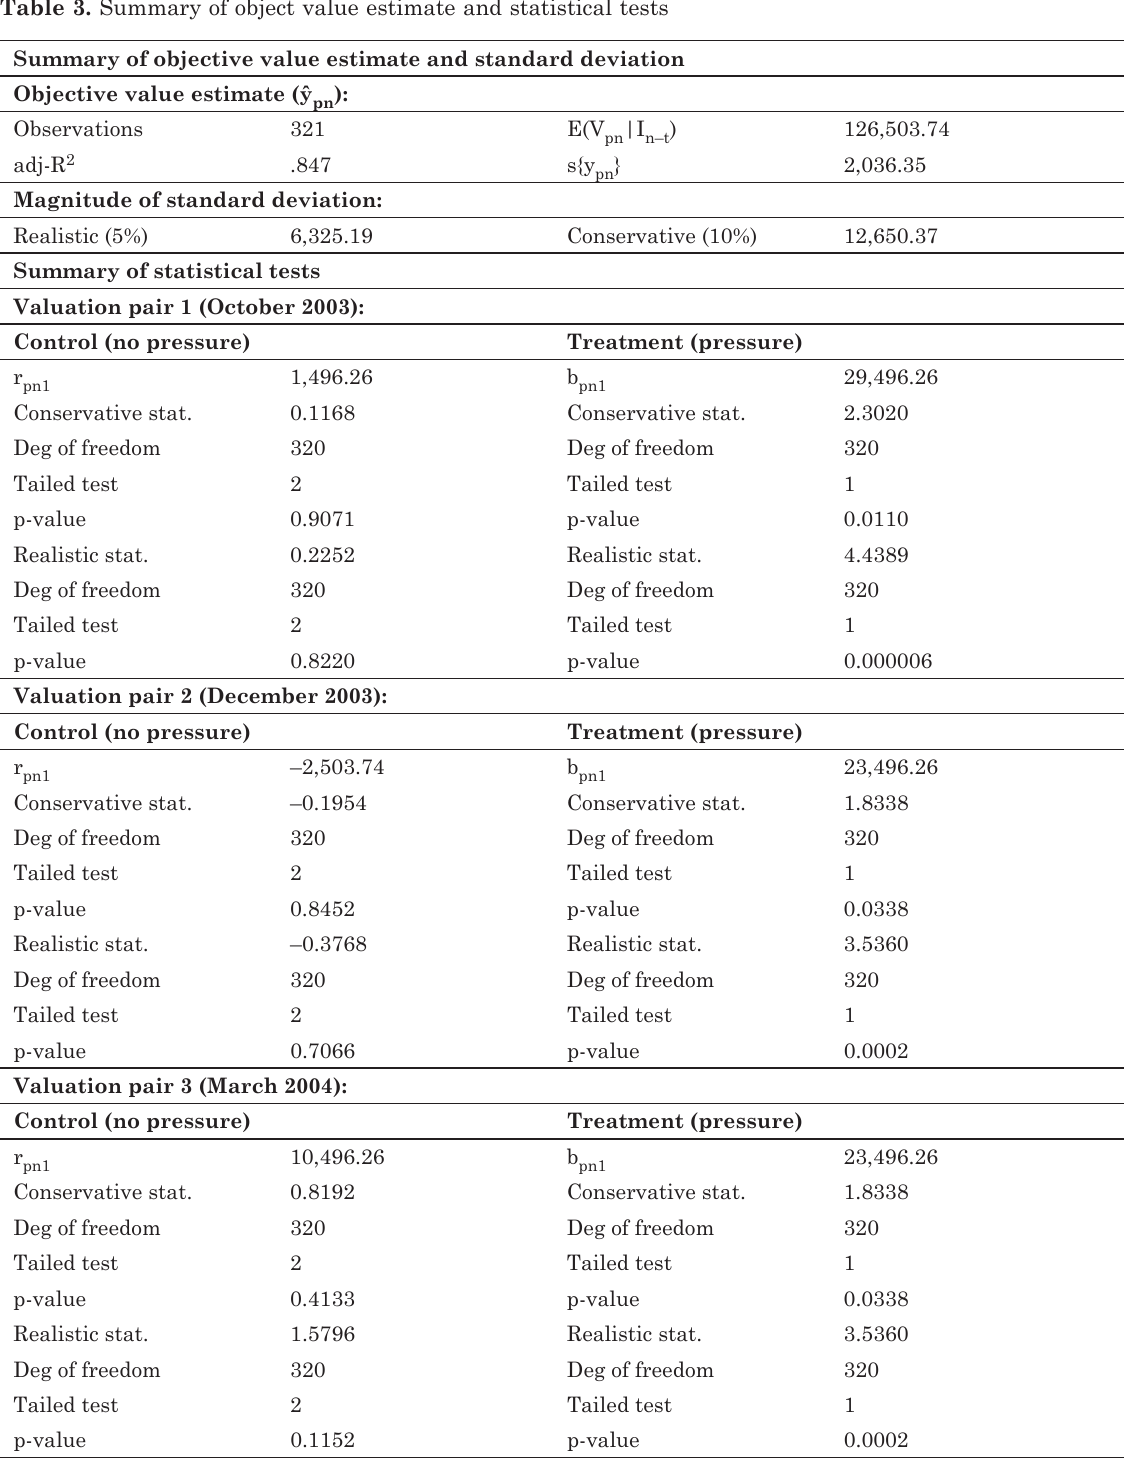
table 3. Summary of object value estimate and statistical tests summary of objective value estimate and standard